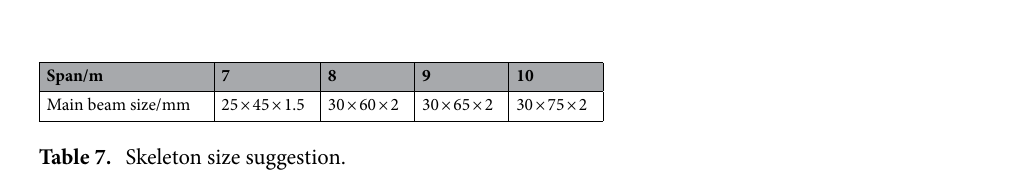
Table 6. Amount and shape of steel used for different wall thicknesses.